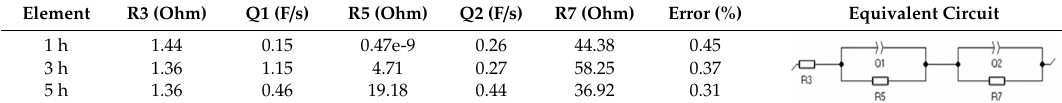
Table 5. Electrochemical parameters obtained from EIS tests of OCT alloy.